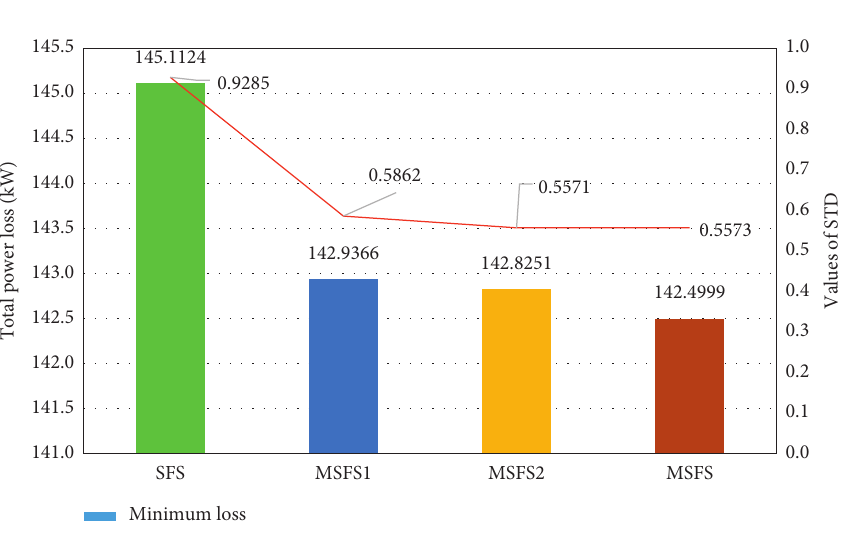
Figure 28: Minimum power loss and standard deviation of 50 trial runs obtained by SFS methods for case 4 of the 85-bus